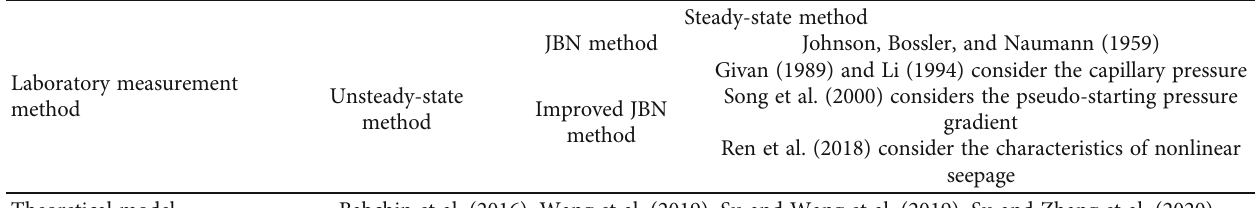
Table 1: Methods to obtain the oil-water relative